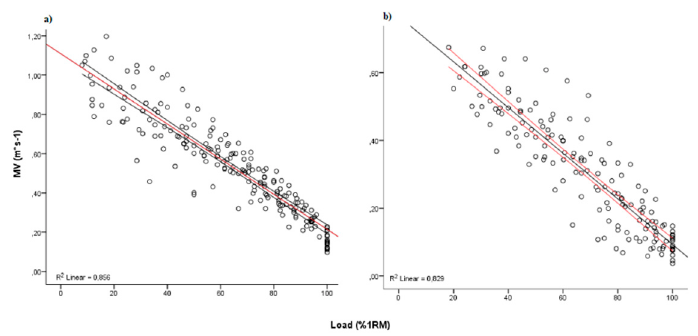
Figure 1. Relationship between training load (%1RM) and mean propulsive velocity (MPV) obtained during ( a ) bench press and ( b ) leg press.MV: Mean Velocity, R 2 : Pearson’s multivariate coefficient of determination. Table 2. Predicted mean propulsive velocity (m·s − 1 ) for the leg press and bench press at each intensity (%1RM).